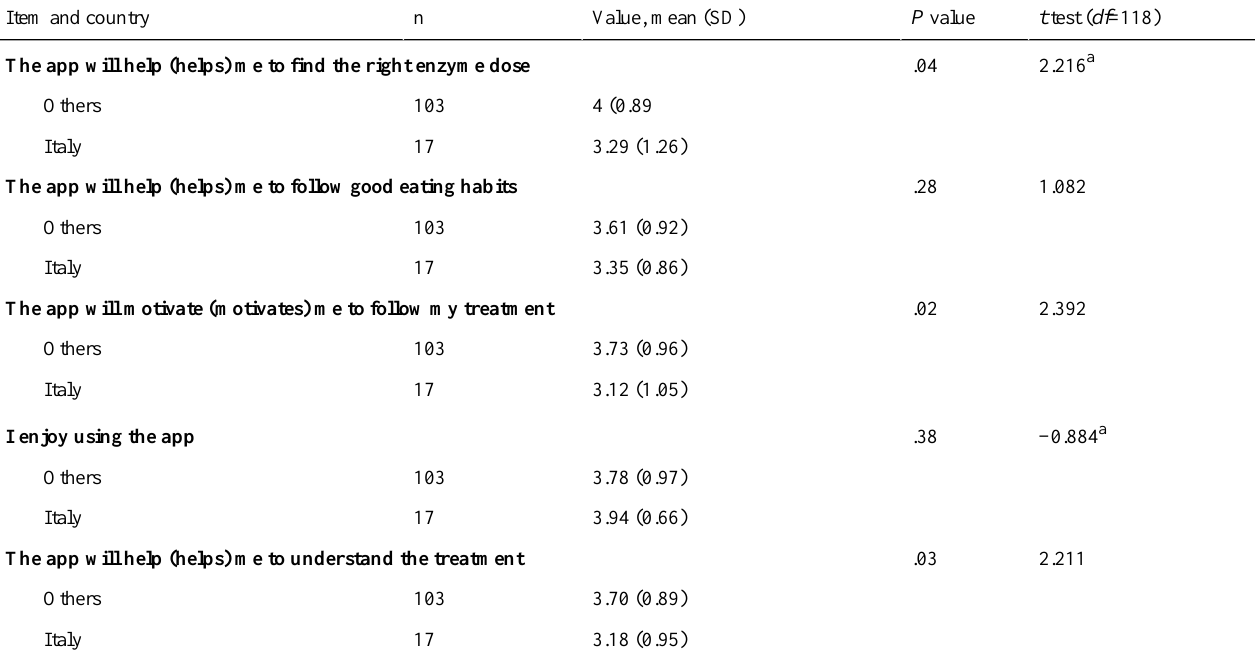
Table 9. Comparison of responses after 1 month between Italy and other